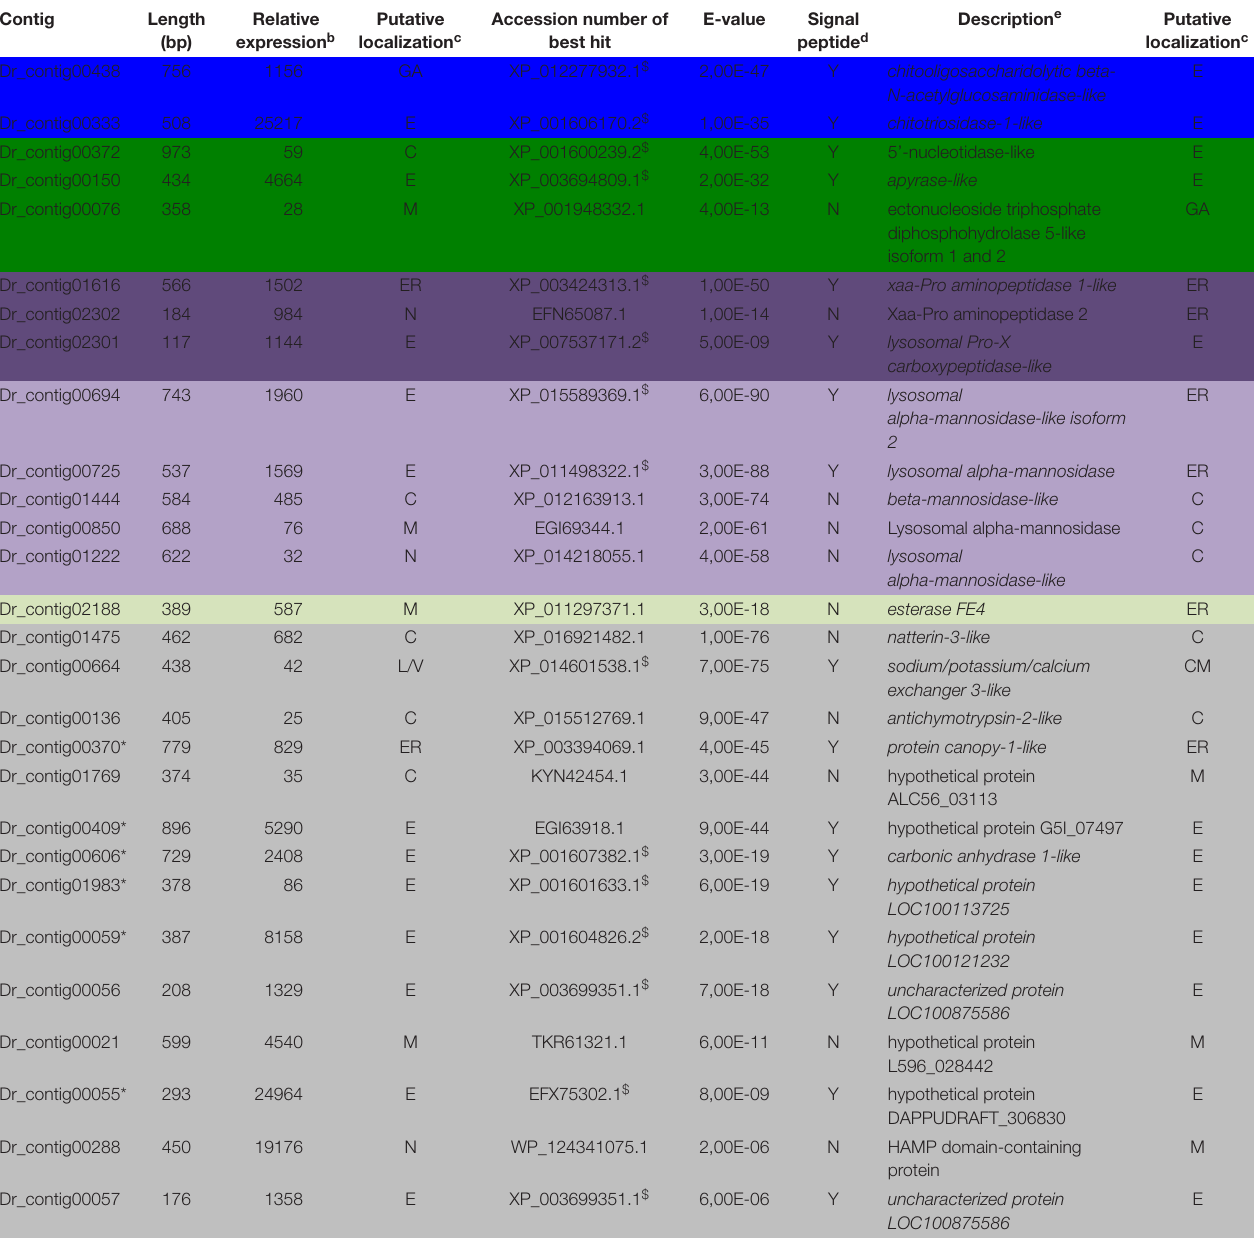
TABLE 3 | Diplolepis rosae contigs differentially expressed in venom glands a . Contig Length